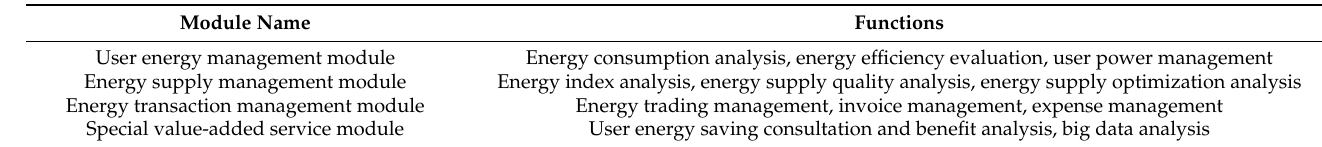
Table 14. The integrated energy management platform modules.